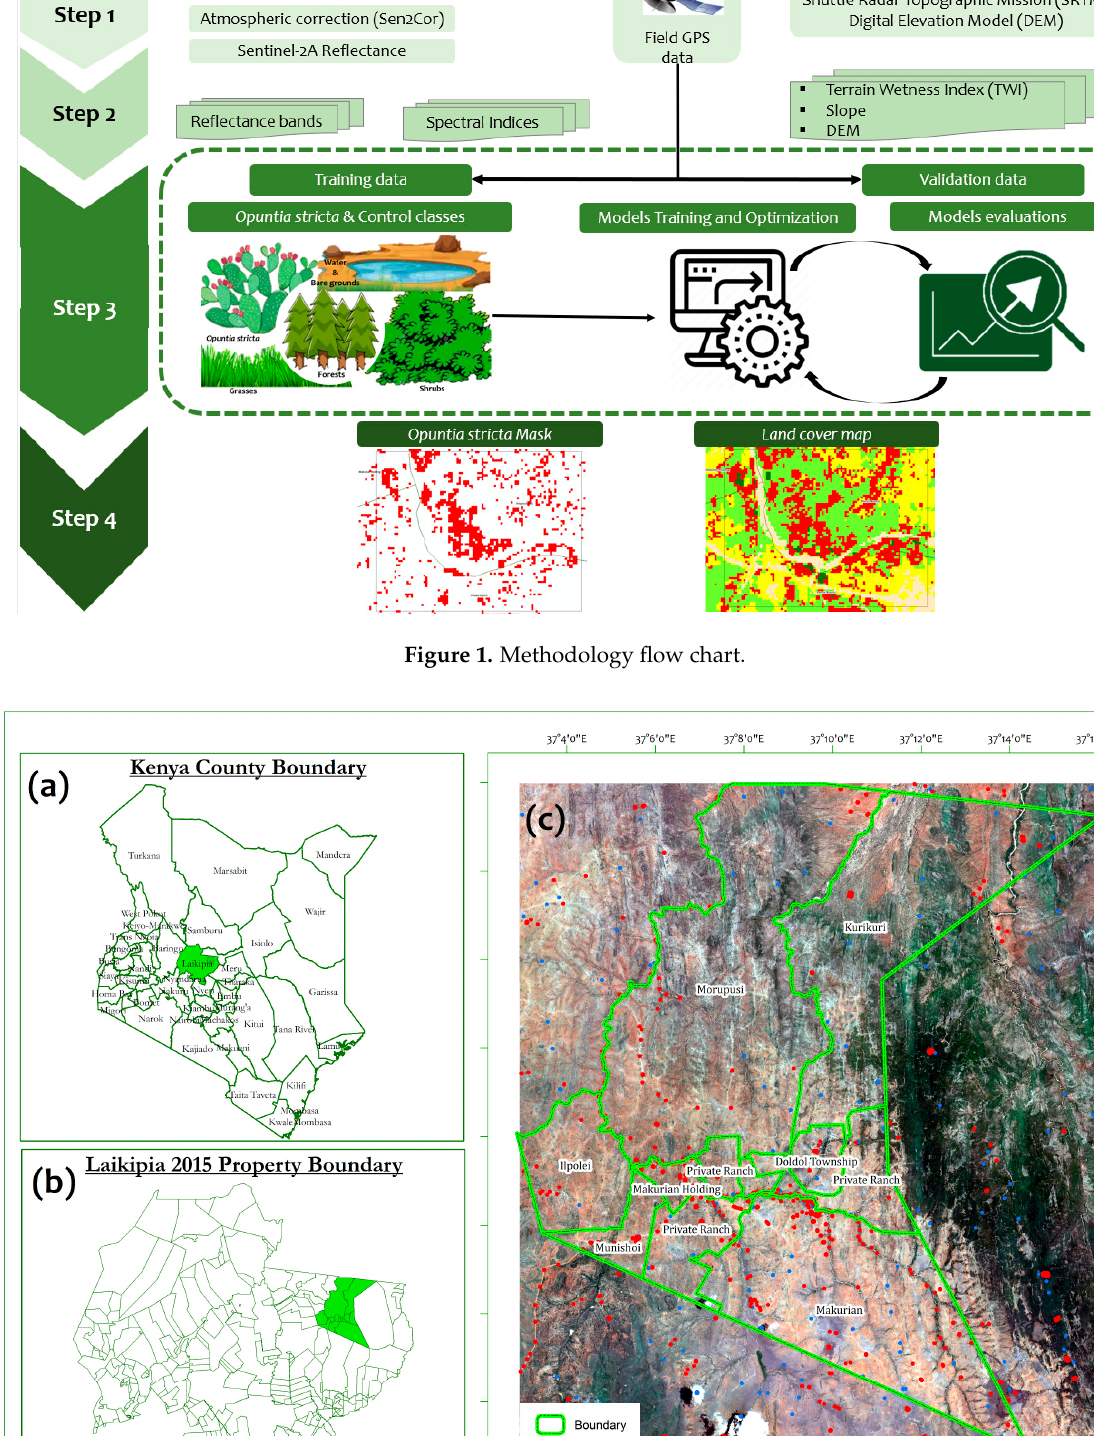
Figure 2. A map showing the study area (panel c ), relative to Laikipia county (panel b ) as well as the location of Laikipia county in Kenya (panel a ). Additionally, we show training (red) and validation (blue) data points. The background image is of Sentinel 2a acquired 16th September 2019.